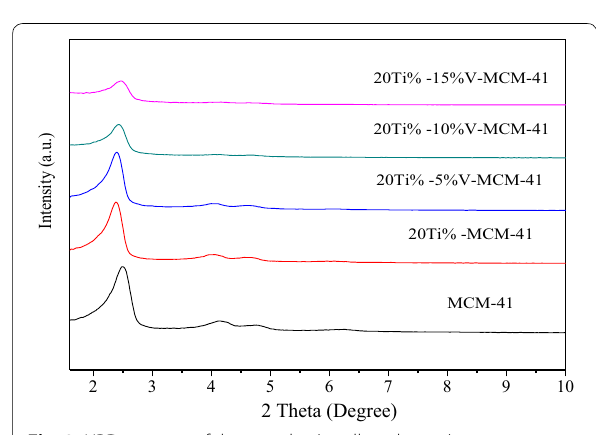
Fig. 3 XRD patterns of the samples (small angle area)